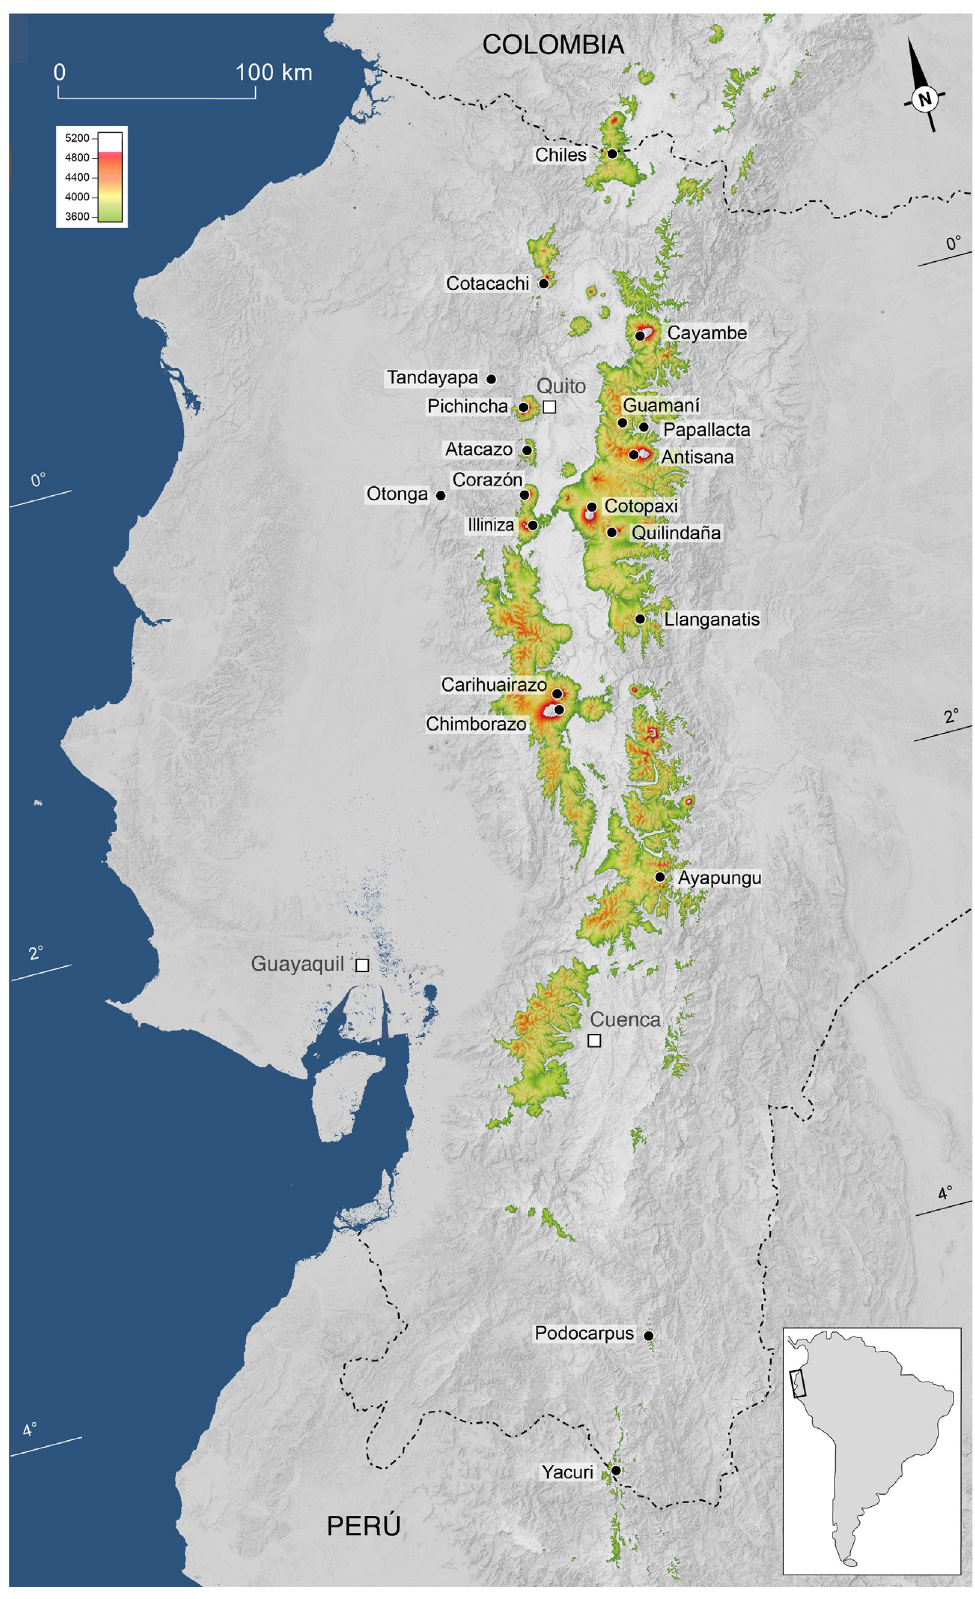
Fig. 1. Map of the Ecuadorian Andes with the localisation of the sampled